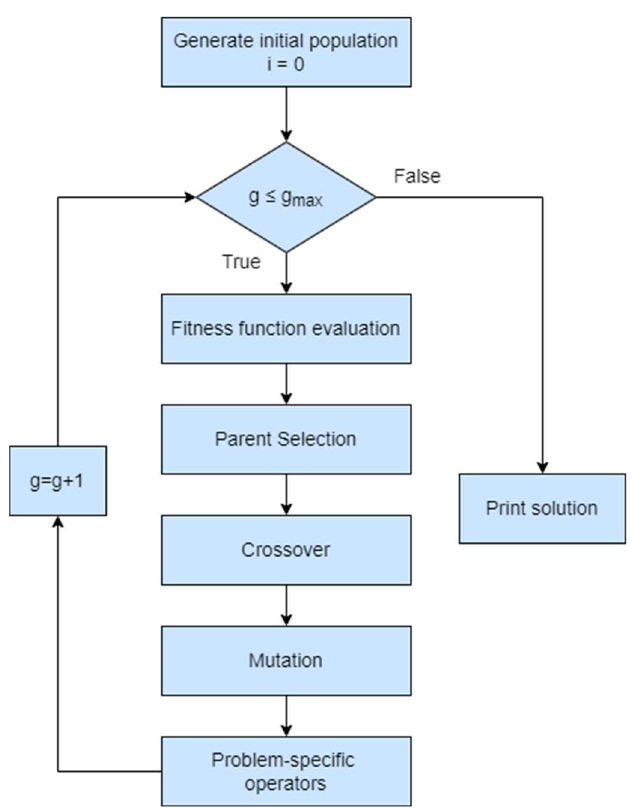
Figure 1. Outline of the GA.